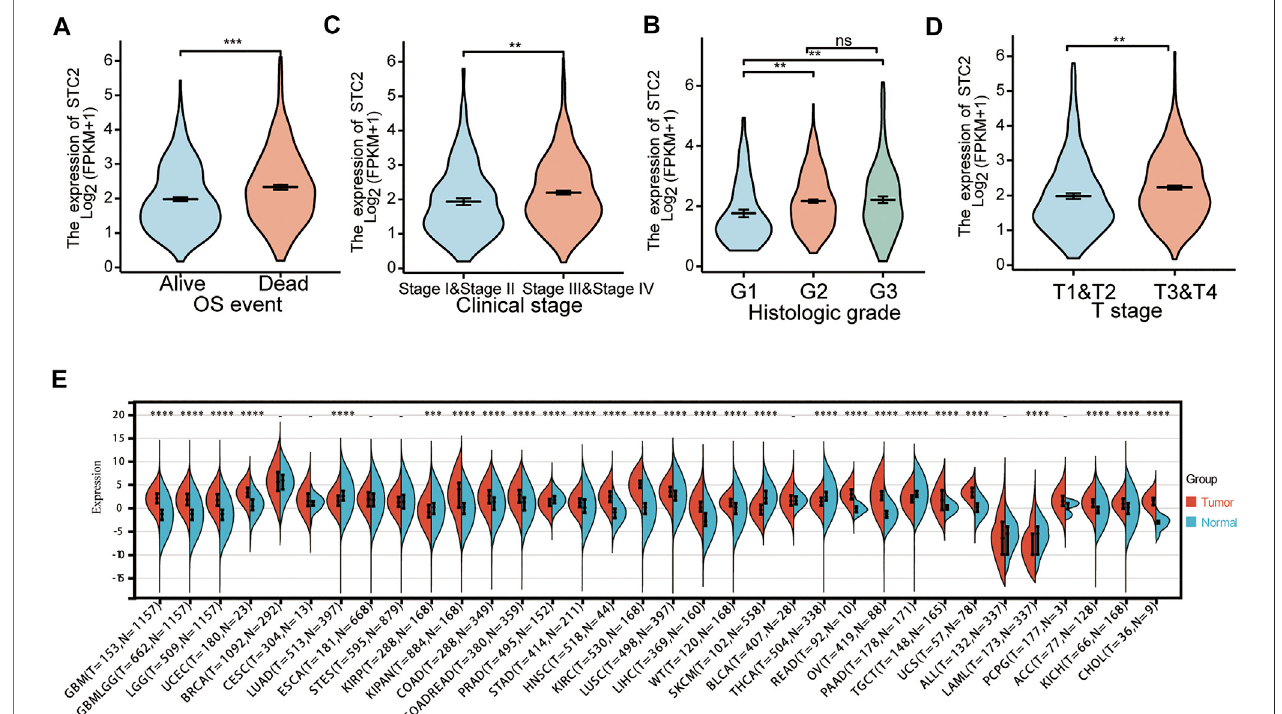
FIGURE 3 | Analysis of the correlation between STC2 expression and clinicopathology. (A) Expression levels of STC2 in different survival status of HNSCC. (B) Expression levels of STC2 in early and advanced cancer. (C) Expression levels of STC2 in different degrees of tumor differentiation. (D) Expression levels of STC2 in different tumor stages. (E) Expression levels of STC2 in 33 cancer types. * p < 0.05; ** p < 0.01; *** p < 0.001; **** p <